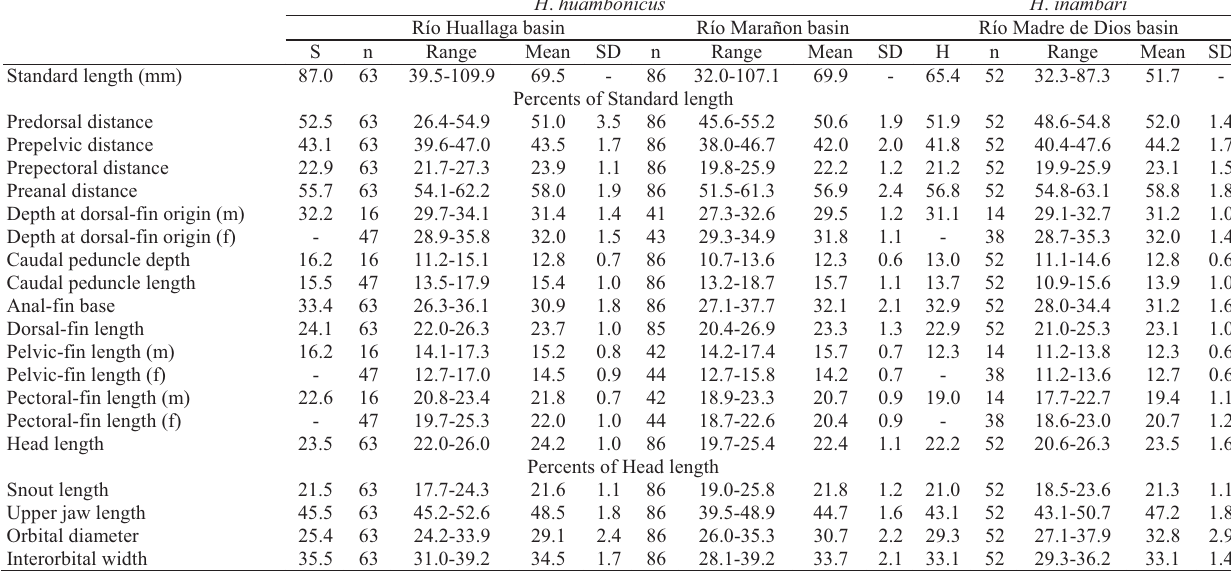
Table 2. Morphometric data of syntype of Hemibrycon huambonicus (S, NMW 57531) from Huambo, Peru, non-types from the upper río Huallaga basin (CAS 70082, 70085, 70089, 70091-93; ICNMHN 7317), and from the upper río Marañon basin (CAS 70083, 70086; ROM 55238, 55406, 55366); and holotype (H, MUSM 35491) and paratypes of Hemibrycon inambari from the upper río Madre de Dios basin (ANSP 143290, 143293, 143307, 143291, 143294, 143300, 143306, 143312, 143317, 151478, 151497, 151526, MCP 45753, MUSM 26299, 26776, 26802, UFRGS 13201). The range includes the holotype. m, males; f, females. SD = Standard